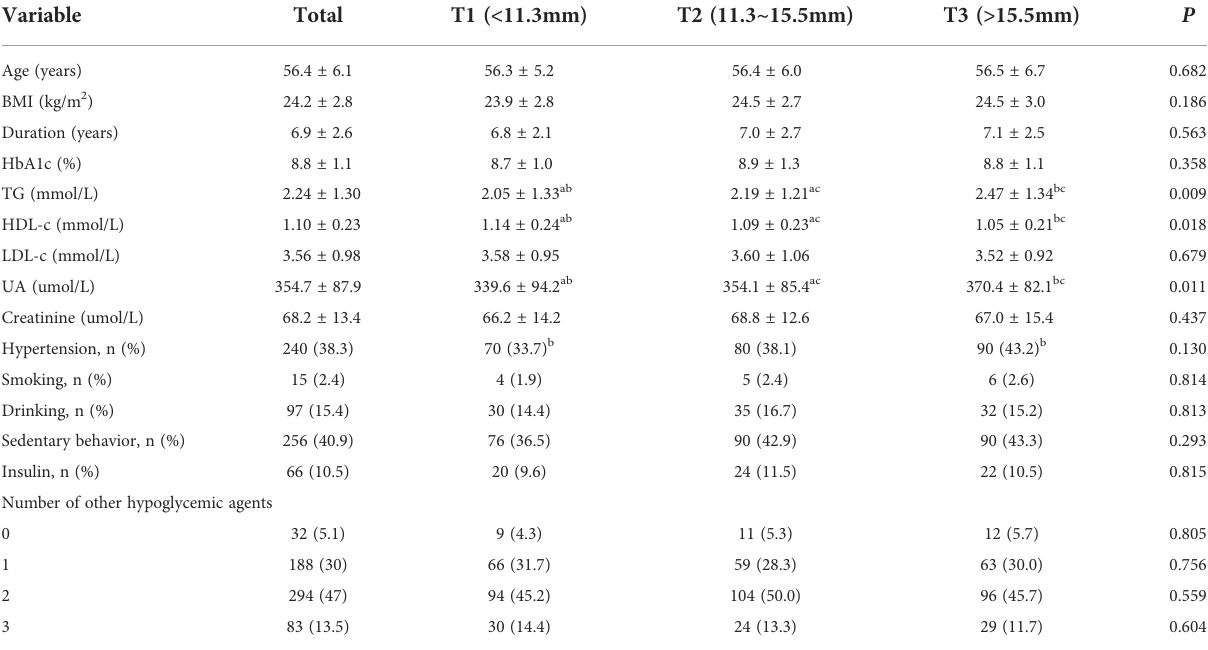
TABLE 1 Clinical and laboratory characteristics of participants based on tertiles of PrFT.